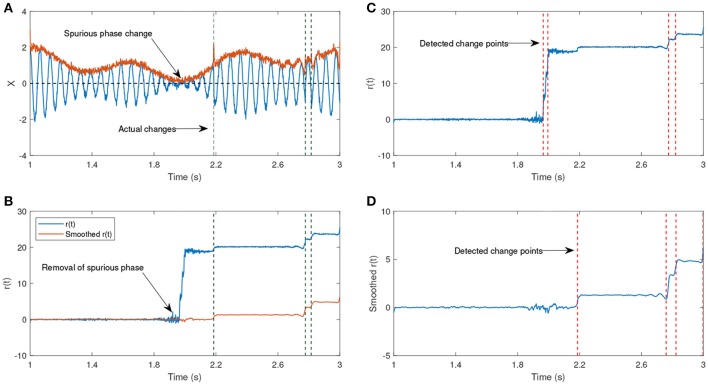
(A) An example of an oscillatory signal which contains a low envelope. The signal length is about 2 s. The vertical lines show the actual shifts in the signal which are random. (B) The phase after removing the line corresponding to the center frequency before and after applying a Kalman smoother (KS). (C) The detected changes in r(t) without any smoothing have been plotted. (D) The detected changes in r(t) after applying KS. (A,B) Have been adapted from Mortezapouraghdam and Strauss (2017) with some modifications.